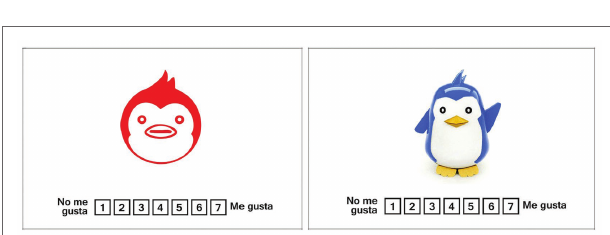
FIGURE 4 | Stimulus layout from the assessment task for icons version (left) and toys version